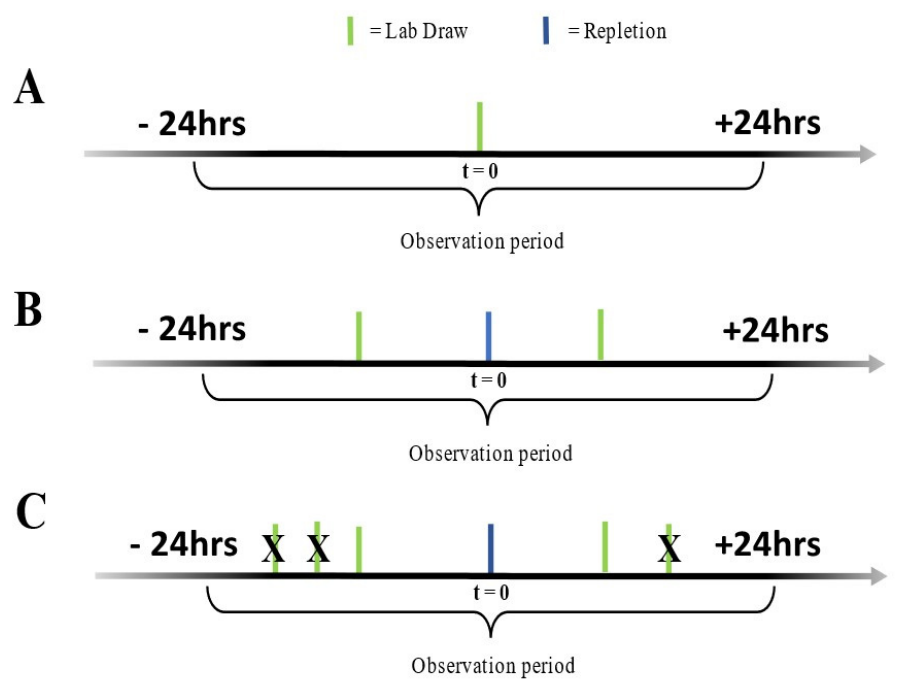
Figure 2. Three different clinical scenarios around the electrolyte replacements. In the first case, only electrolyte lab draw was obtained without preceding electrolyte replacement, and subsequent supplementation was given within 24 h ( A ). The lab draw was preceded by a singular electrolyte replacement ( B ) or multiple electrolyte replacements ( C ) in two other scenarios.